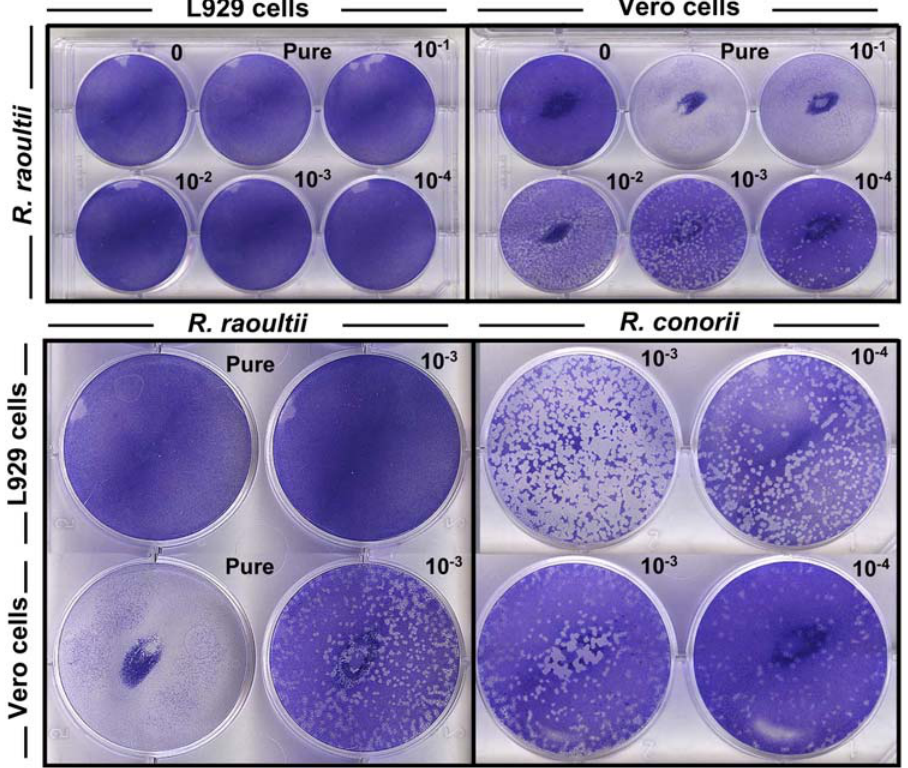
Figure 6. Plaque formation by R.raoultii and R.conorii in different cell lines. L929 or Vero cells monolayers were infected for 10 days with serial dilutions of bacteria, the pure inoculum being estimated by qRT-PCR as 2.5 6 10 7 rickettsiae per well. The ‘‘control’’ corresponds to non-infected cells. Upper panel: After crystal violet-staining we noticed the absence of plaque formation in L929 cells infected with R. raoultii (left) while a concentration-dependent effect was observed on Vero cells (right). Lower panel: Magnification of the effects observed with R. raoultii or with R. conorii .